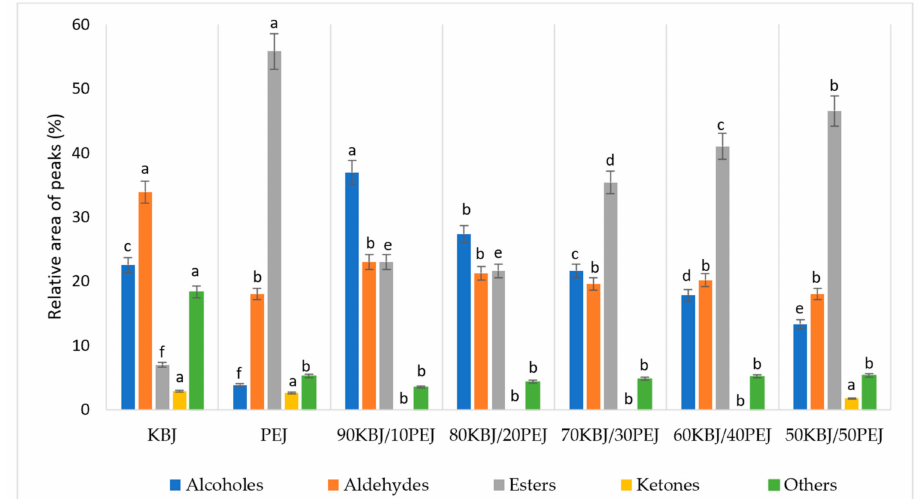
Figure 2. Relative area of peaks (%) for the MTX-G column of the main volatile compounds identified in the headspace of kiwiberry and pear juice and their mixes. Means ( n = 3) with different small letters (a–f) in the same chemistry family group are significantly different ( p ≤